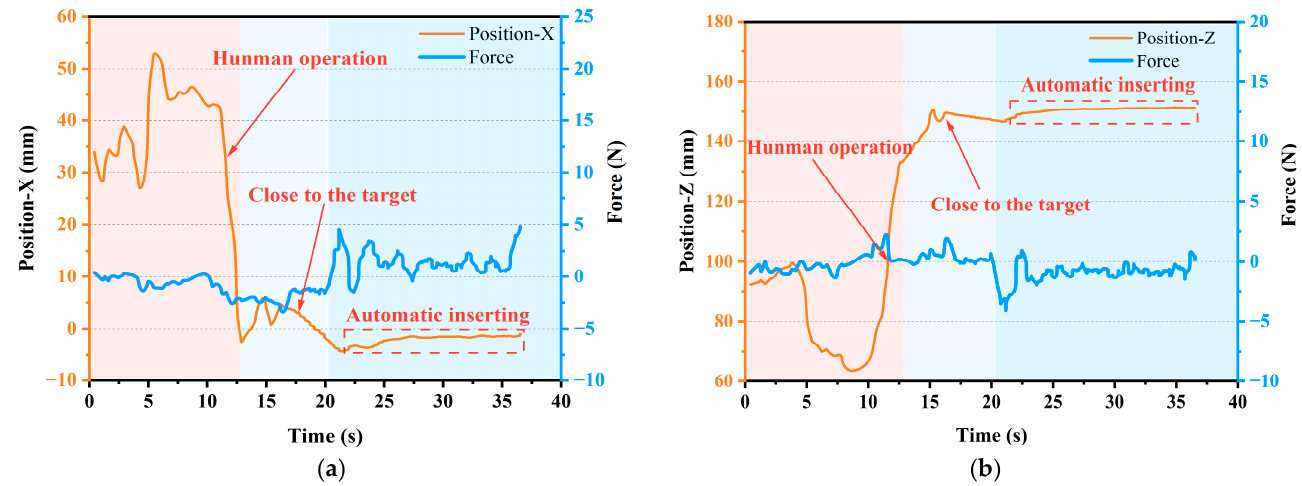
Figure 9. The contact force and the trajectory by manual/automatic mixed controller ( a ) in X axis; ( b ) in Z axis.